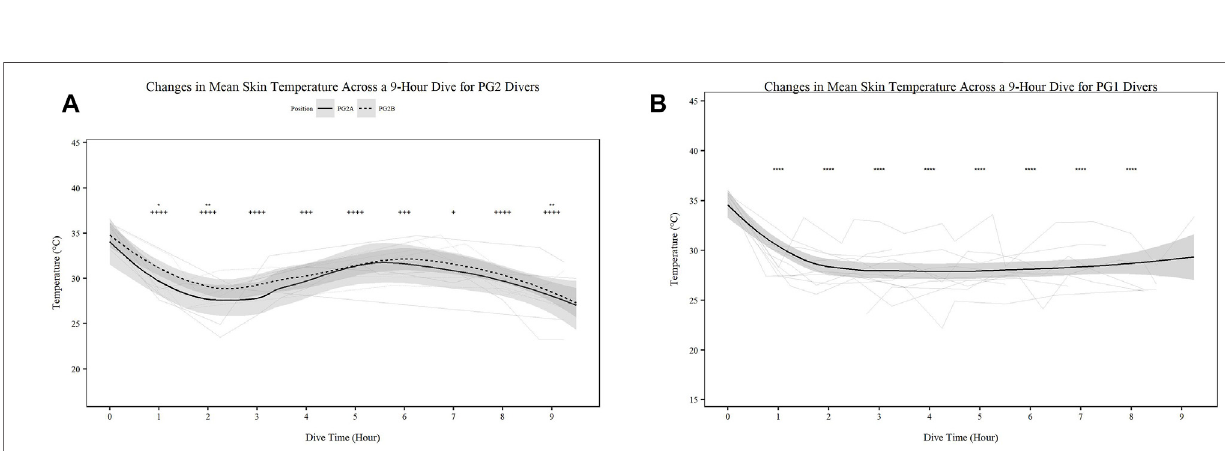
Frontiers in Physiology |